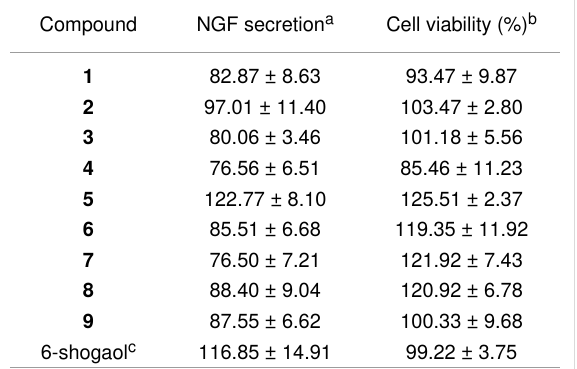
Table 5: Effects of compounds 1 – 9 on NGF secretion in C6 cells.